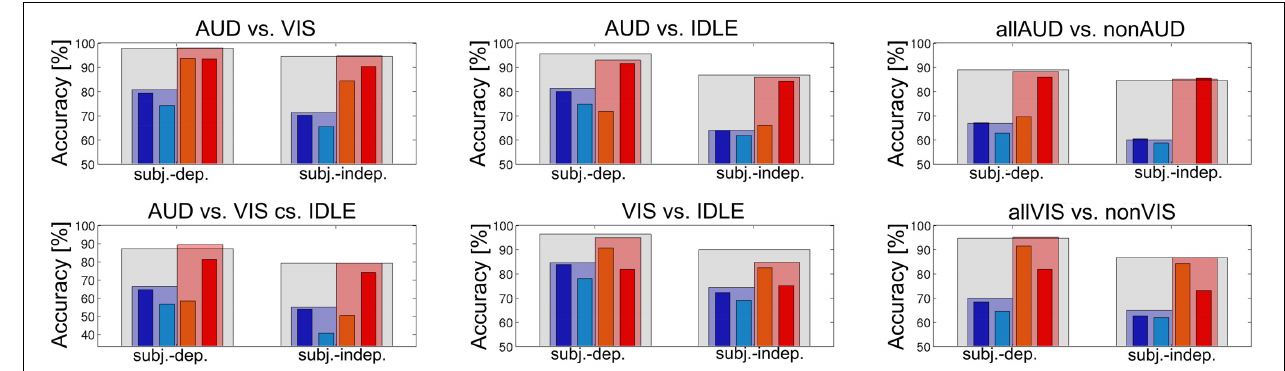
FIGURE 8 | fNIRS-META (red) vs. EEG-META (blue) evaluated for both subject-dependent and subject-independent classification for different conditions.